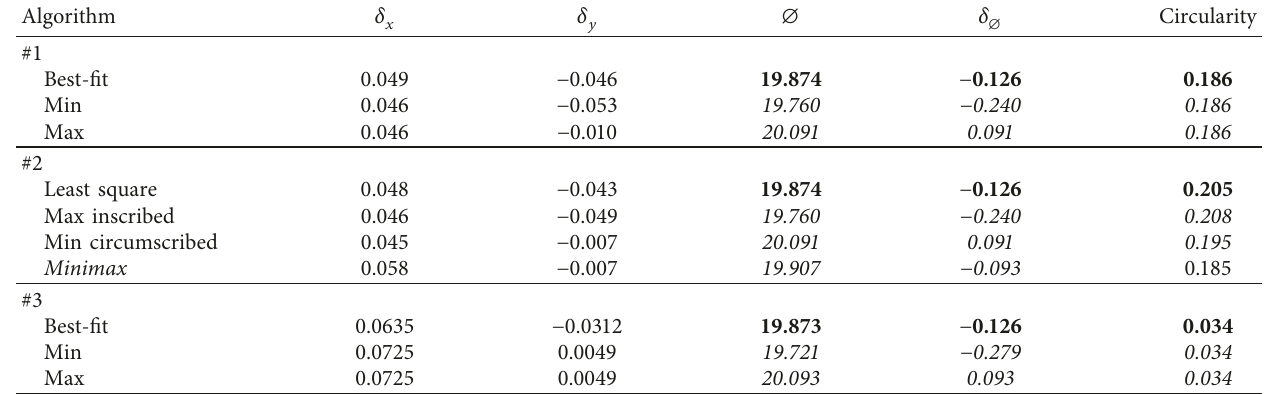
Table 3: Results of inspection circle #2 ( ∅ 20mm).